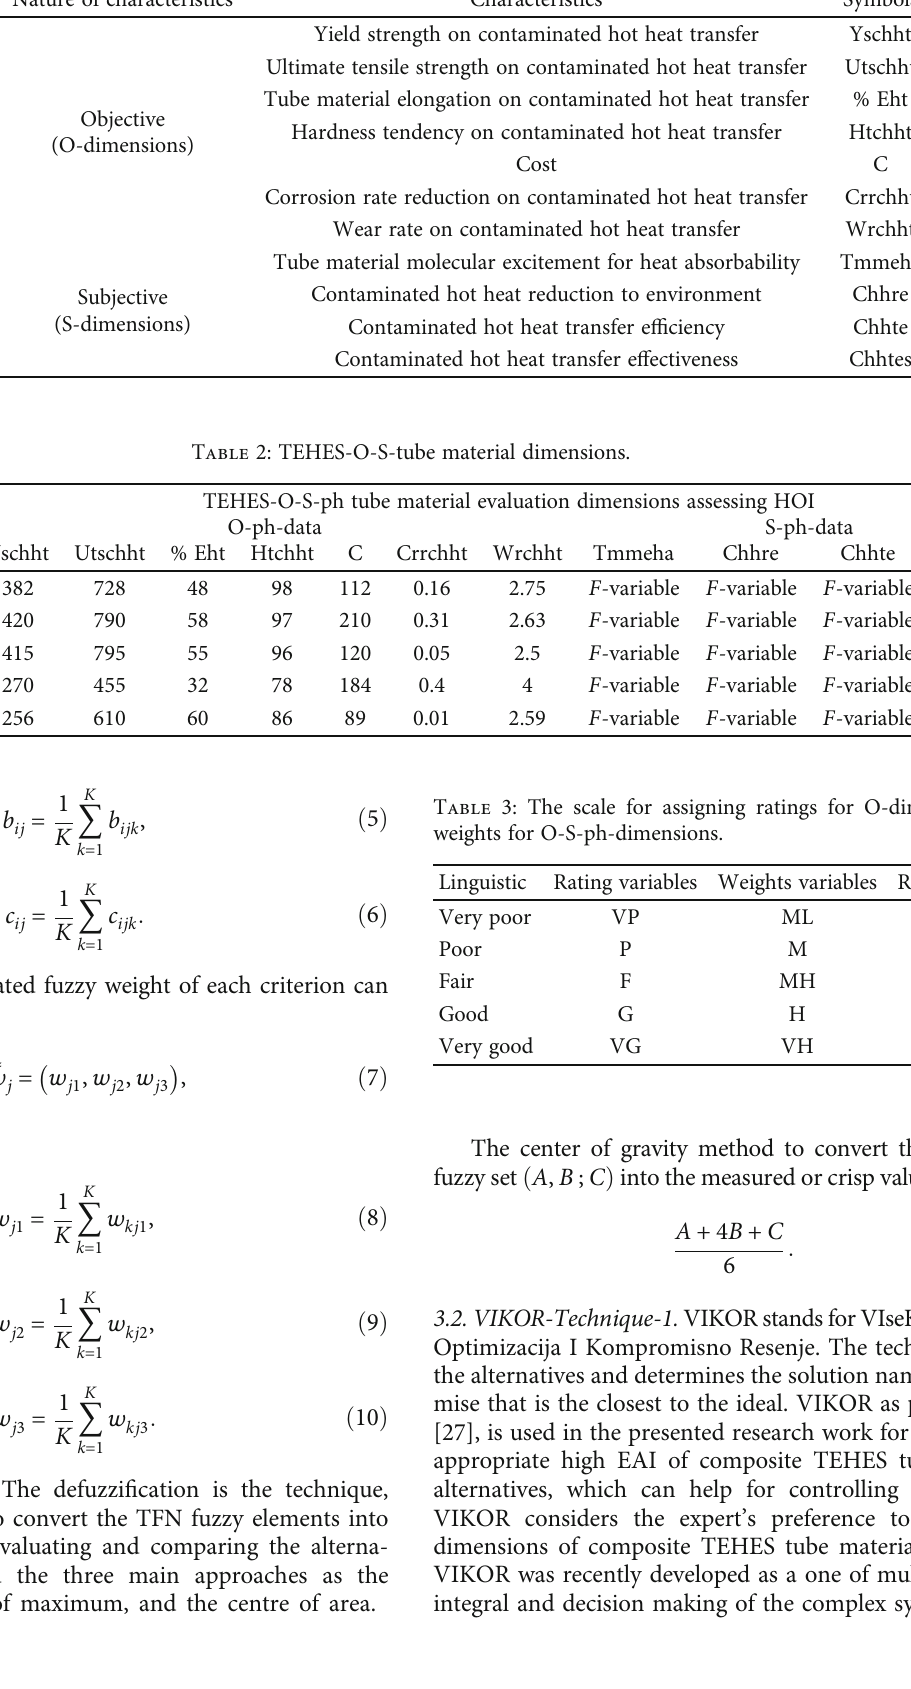
Table 1: Developed and proposed TEHES-O-S-composite tube material evaluation model for assessing EAI and controlling the GWAP. Model